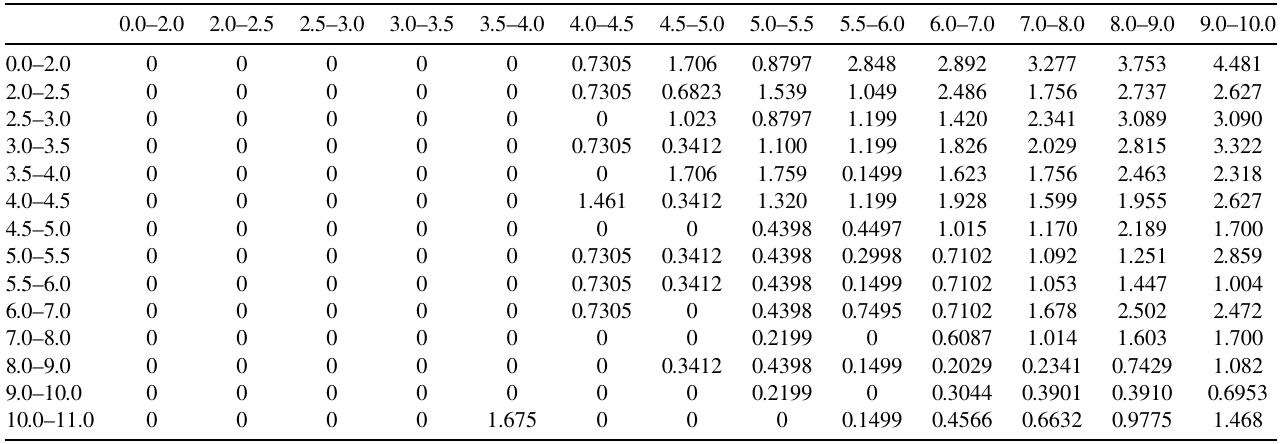
TABLE XV. (cid:4) þ background from (cid:3) (cid:5) CC events (all values (cid:2) 10 (cid:1) 4